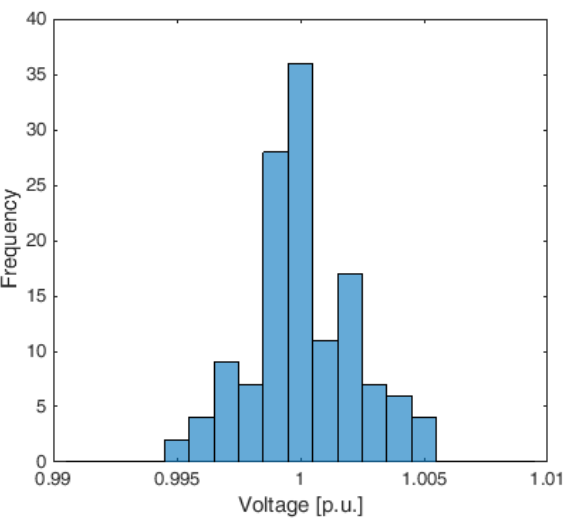
Figure 3. The histogram of the grid voltage amplitudes in Case 3 for the Benchmark VOP .